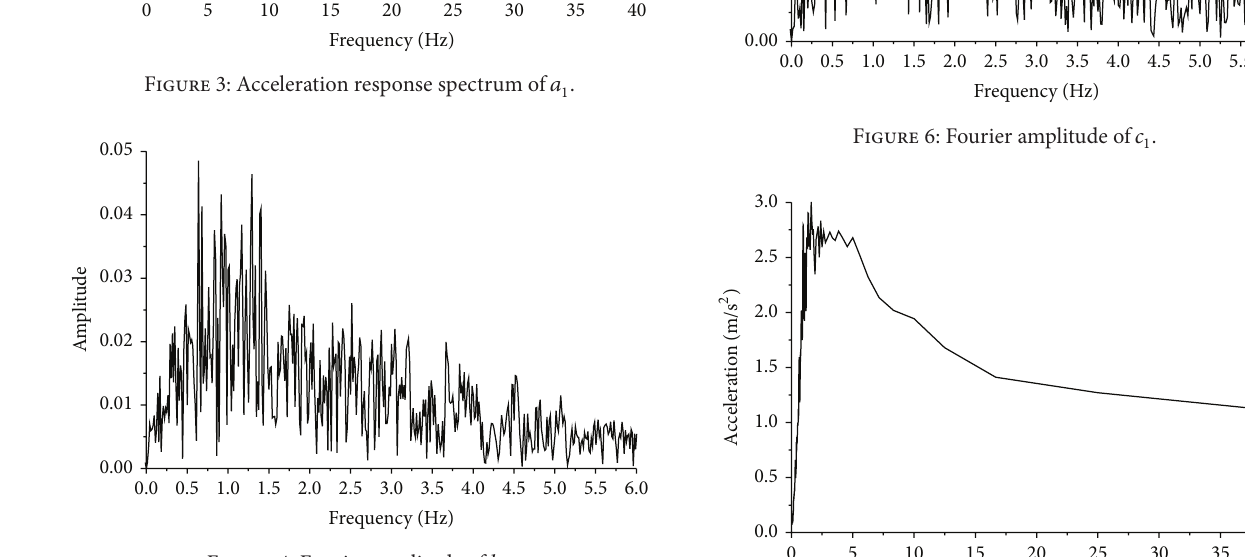
Figure 4: Fourier amplitude of 𝑏 1 .